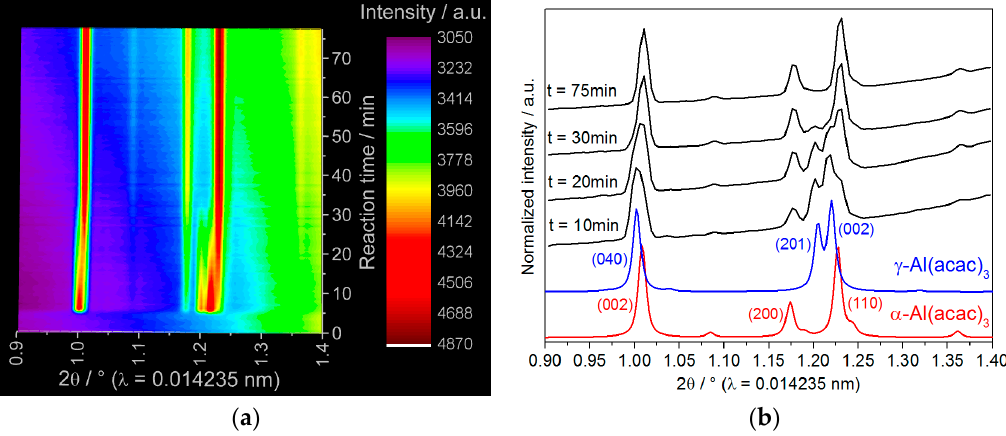
Figure 1. ( a ) Time-resolved XRD patterns during the formation of Al(acac) 3 , recorded at the PETRA III beamline P07B (room temperature, concentration of NH 3 25%); ( b ) XRD pattern after 10, 20, 30, and 75 min of reaction time and the calculated patterns of the polymorphs [33–35].